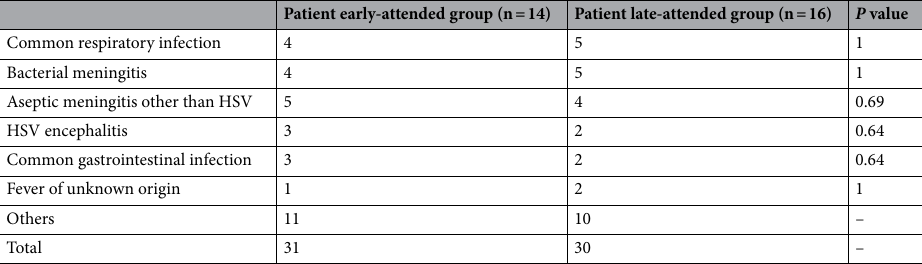
Table 6. Frequency of common misdiagnoses in the patient early-attended and late-attended groups. HSV herpes simplex